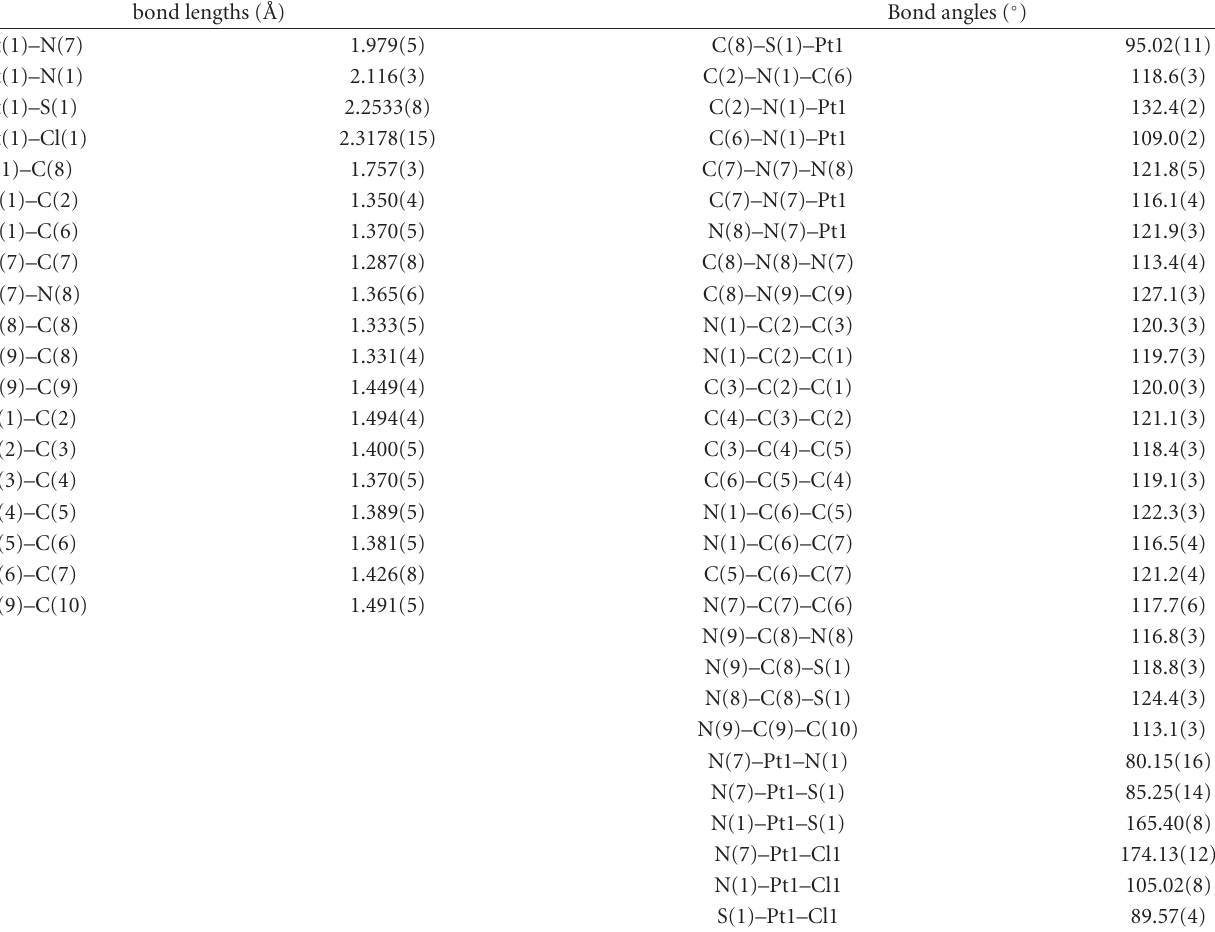
Table 7: Selected bond lengths and bond angles for the [Pt(mpETSC)Cl] complex.